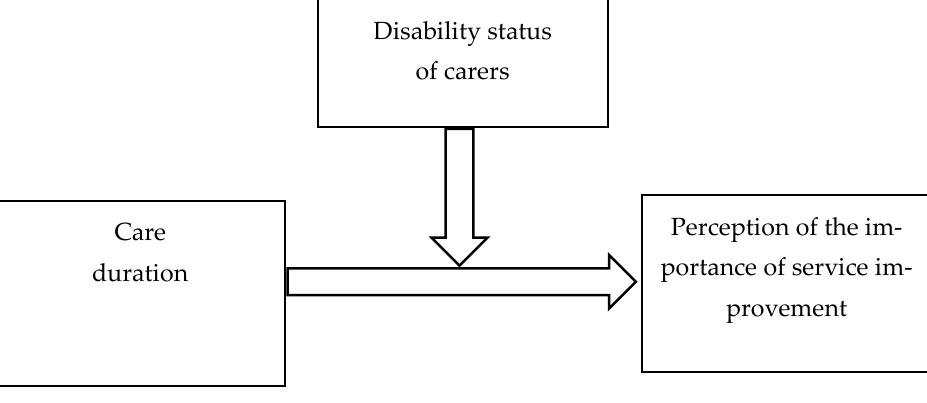
Figure 1. Conceptual model.